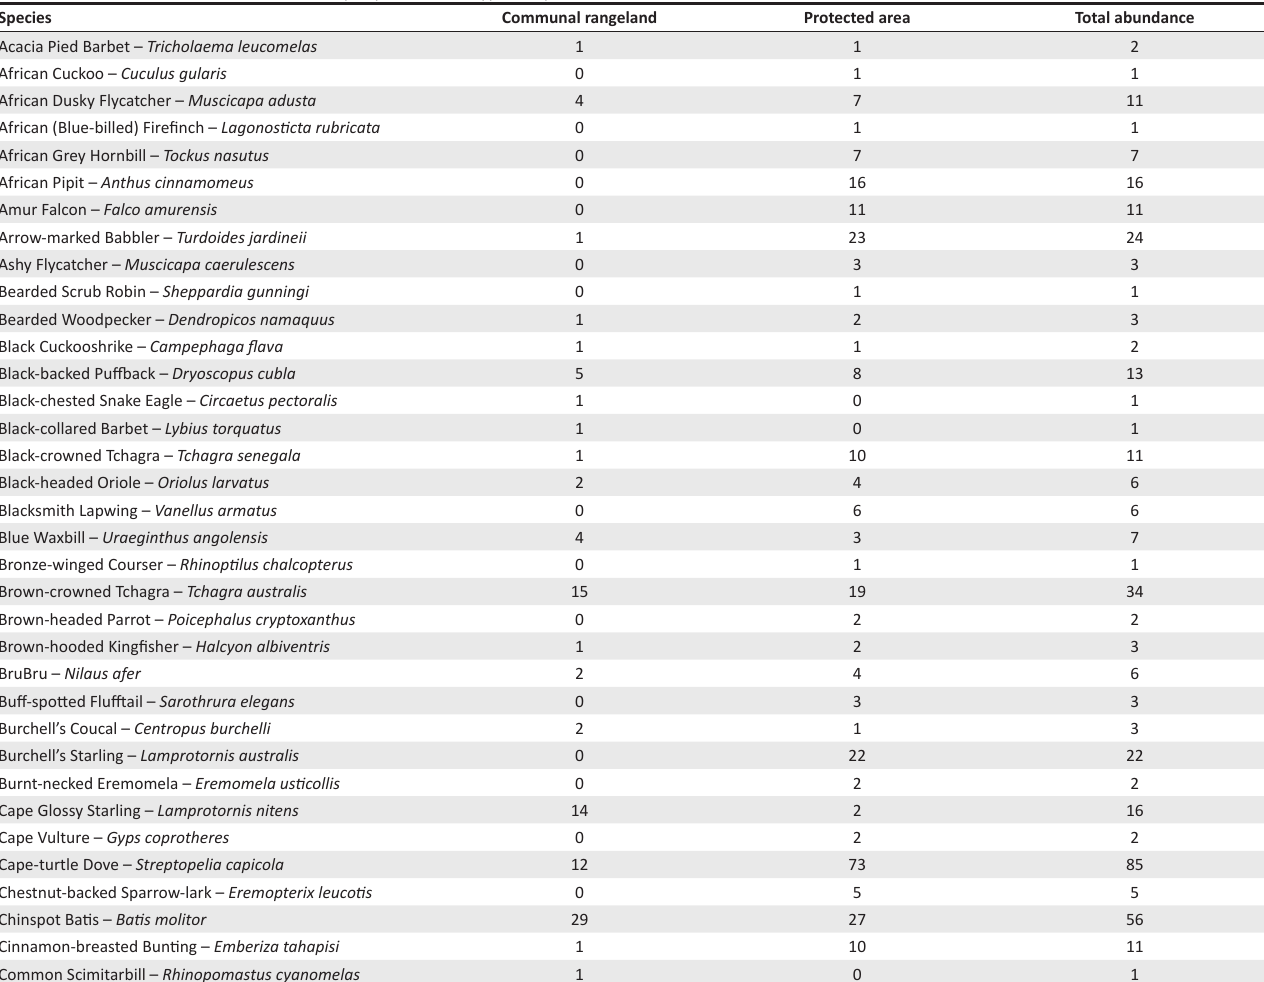
TABLE 3-A1: Cumulative counts of birds surveyed per land-use type in alphabetical order.